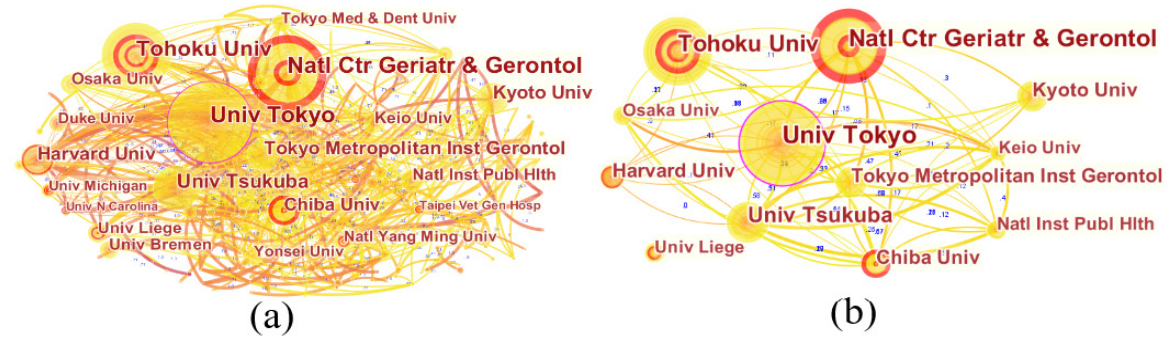
Figure 4. A visualization of the institution collaboration network: ( a ) all institutions; ( b ) top 15 pro- ductive institutions. Table 2. Top 12 productive institutions.